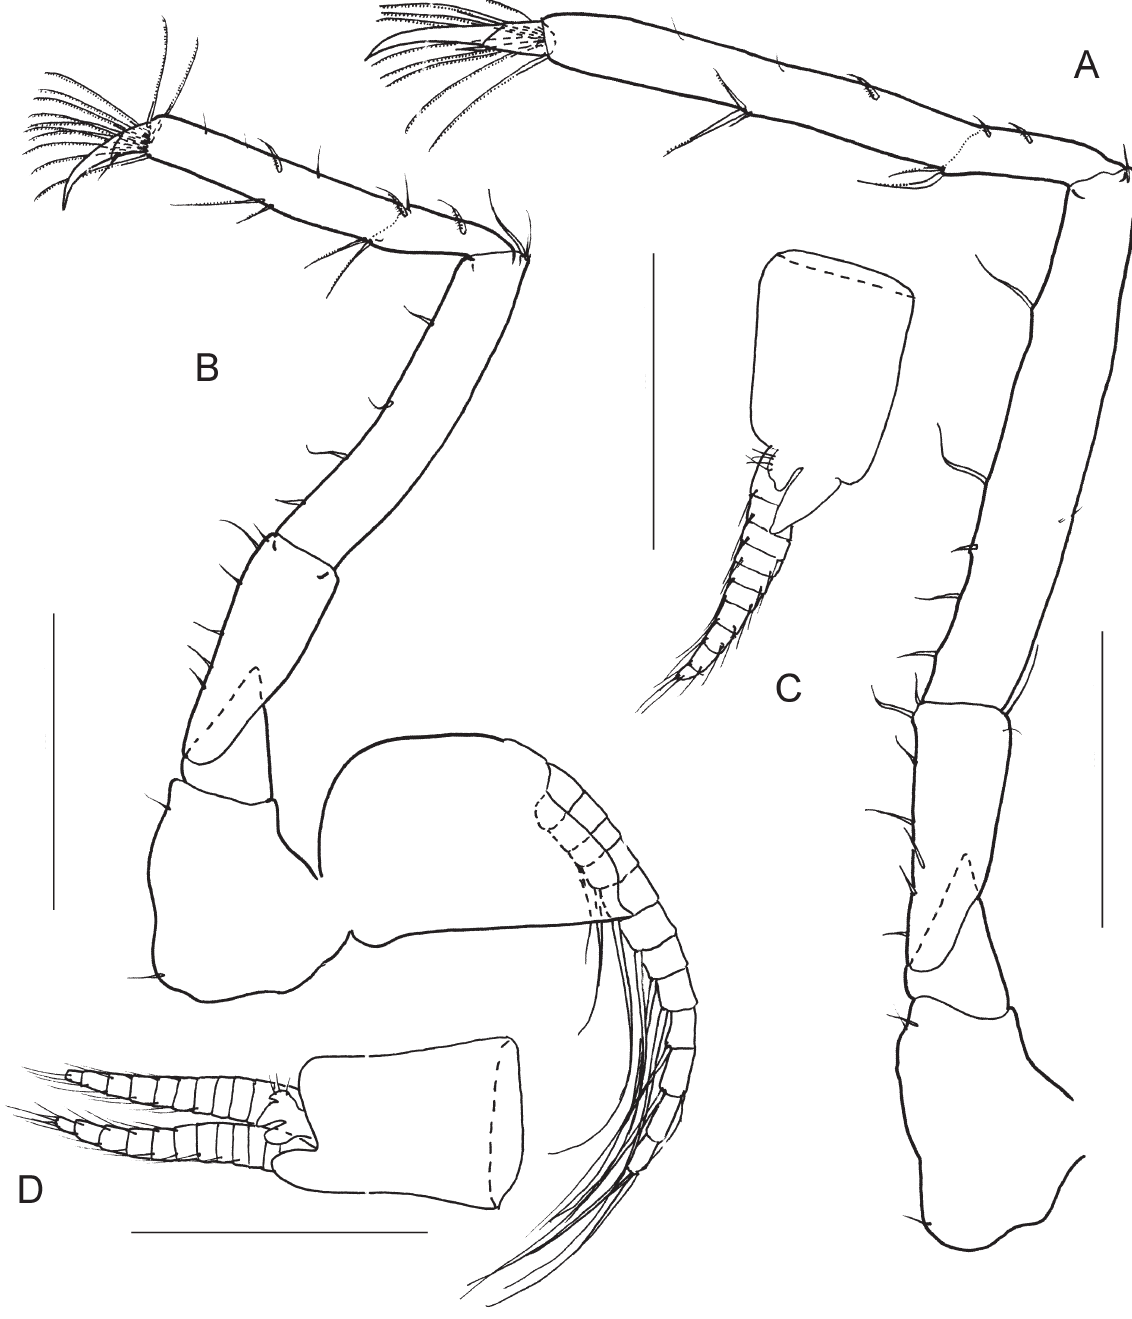
Fig. 34. Siriella cf. chaitiamvongae Murano & Fukuoka, 2008, subadult ♂, Singapore. A . Pereopod 1 endopod, anterior view. B . Pereopod 6, anterior view. C . Pleopod 1, posterior view. D . Pleopod 4, posterior view. Scale bars: 0.25